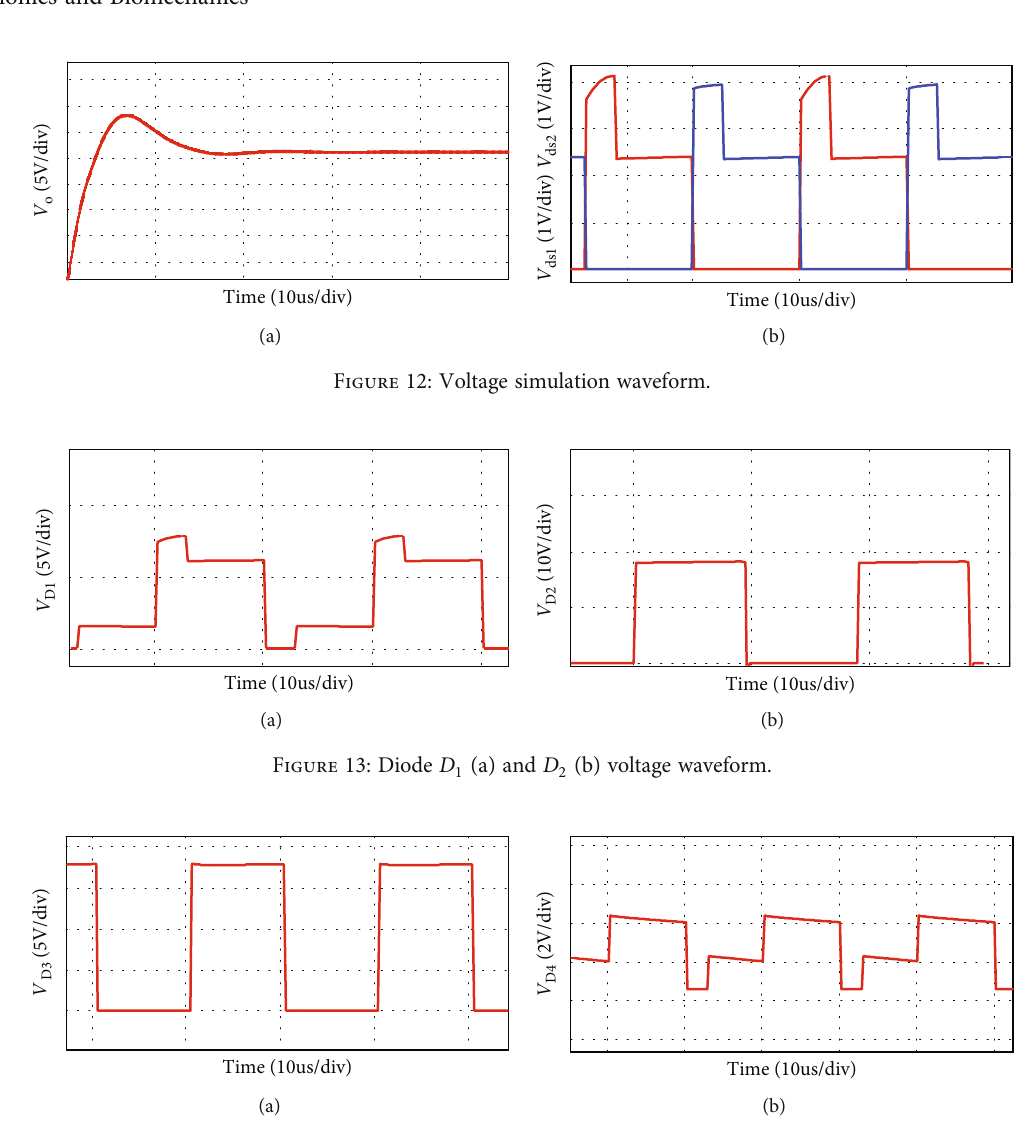
(a) and D (b) voltage waveform. 3 4 Table 5: Simulation results under seawater battery output